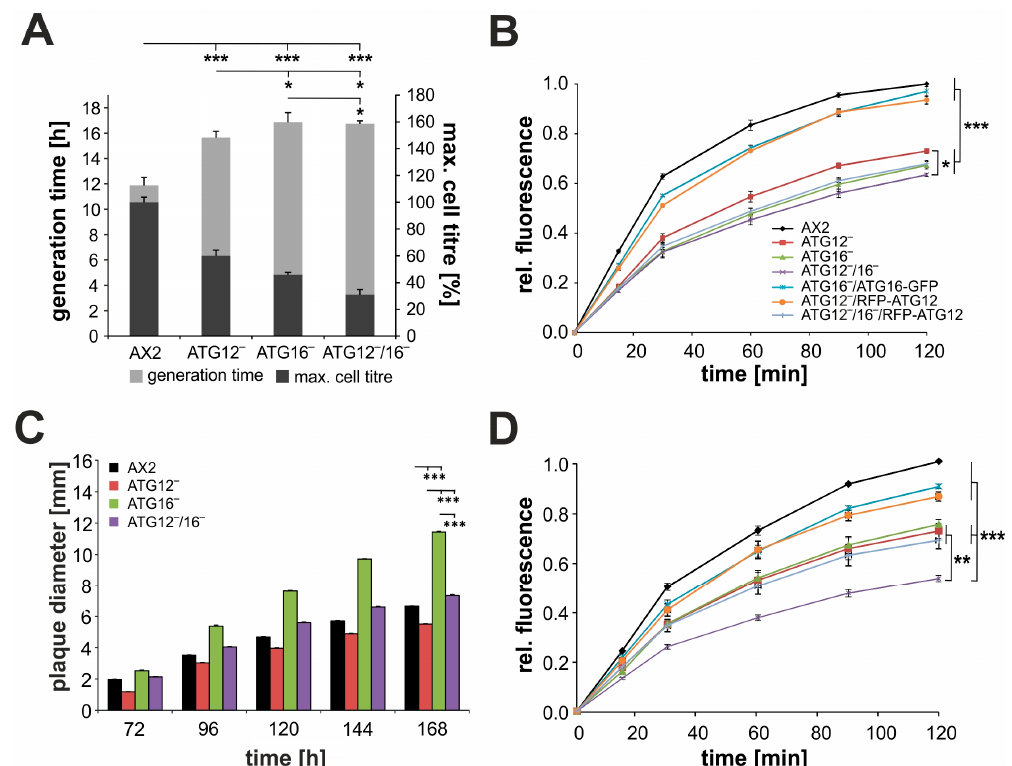
Figure 6. Analysis of endocytosis in AX2 and mutant strains. ( A ) Generation time and maximal cell titre of AX2, ATG12 − , ATG16 − , and ATG12 − /16 − cells in shaking culture. The p -values refer to the difference in maximal cell titre. ( B ) Macropinocytosis of TRITC-labelled dextran. The analyzed Dictyostelium strains were adjusted to 6 × 10 6 cells/mL and TRITC-dextran was added at a final concentration of 2 mg/mL. Macropinocytosis was measured as relative fluorescence for 2 h at the indicated time points. The final fluorescence of AX2 was set to 1. ( C ) Growth of AX2, ATG12 − , ATG16 − , and ATG12 − /16 − cells on a lawn of K. aerogenes . Plaque diameters were quantified every 24 h from day 3 until day 7 after plating of D. discoideum cells. Mean values and SEM of 100 plaques are depicted. For statistical analysis the Dunn-Bonferroni test, implemented in R as post hoc analysis, was performed. Statistical significance between AX2 and the different knock-out strains is depicted for the 168 h time point. ( D ) Phagocytosis of TRITC-labelled yeast is impaired in mutant strains. Cells were resuspended at 4 × 10 6 cells/mL in Soerensen’s phosphate buffer and fluorescent yeast cells were added in a six-fold excess. Phagocytosis was determined as relative fluorescence for 2 h at different time points. The final fluorescence of AX2 was set to 1. The same color code as in (B) was used. For statistical analysis in A, B, and D Tukey’s test, implemented in R, was used as post hoc analysis, and mean values and SEM of three independent experiments were calculated. *** p ≤ 0.001; ** p ≤ 0.01; * p ≤